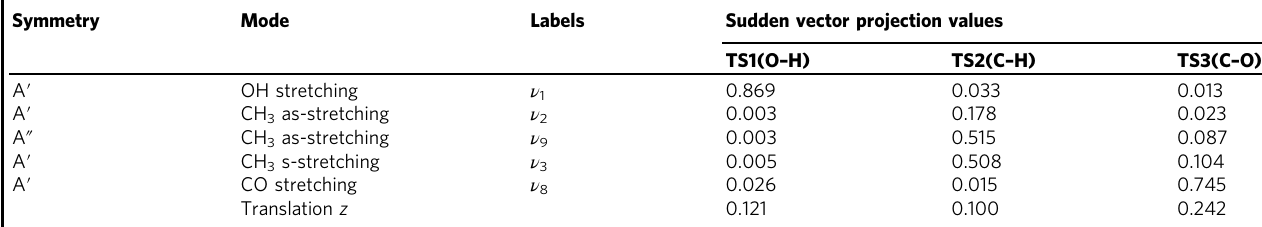
Table 2 Sudden vector projection values of stretching vibrational modes and translation along surface normal associated with three transition states for various bond scissions Symmetry